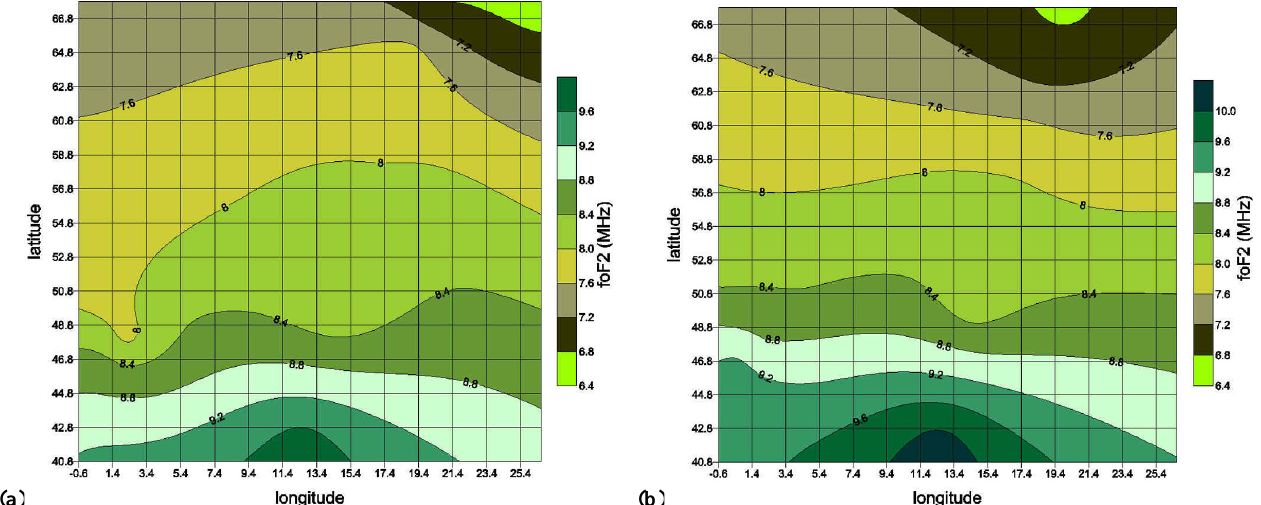
Fig. 3. (a) Map obtained from fo F2 measurements and (b) forecasting map for fo F2 one hour in advance generated using the IFERM model on 11 September 1991 at 13:00UT under disturbed geomagnetic conditions (ap( τ = 0 . 8 ) = 26 . 3; ap( τ = 0 . 9 ) =